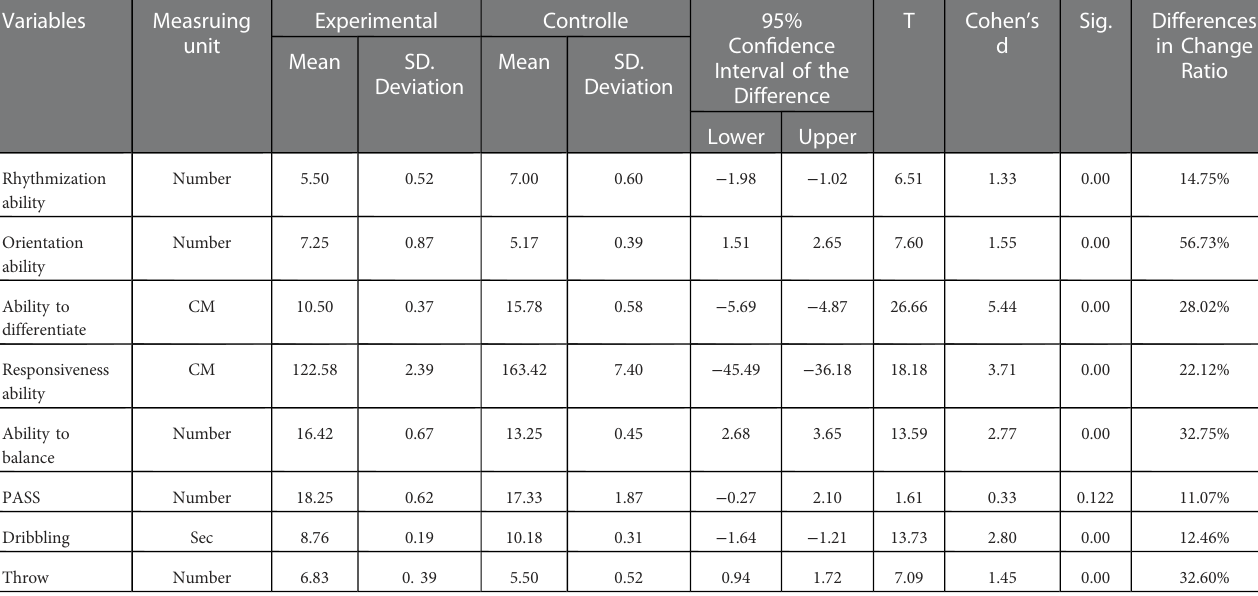
T Cohen ’ s Sig. Differences Con fi dence d in Change Interval of the Difference